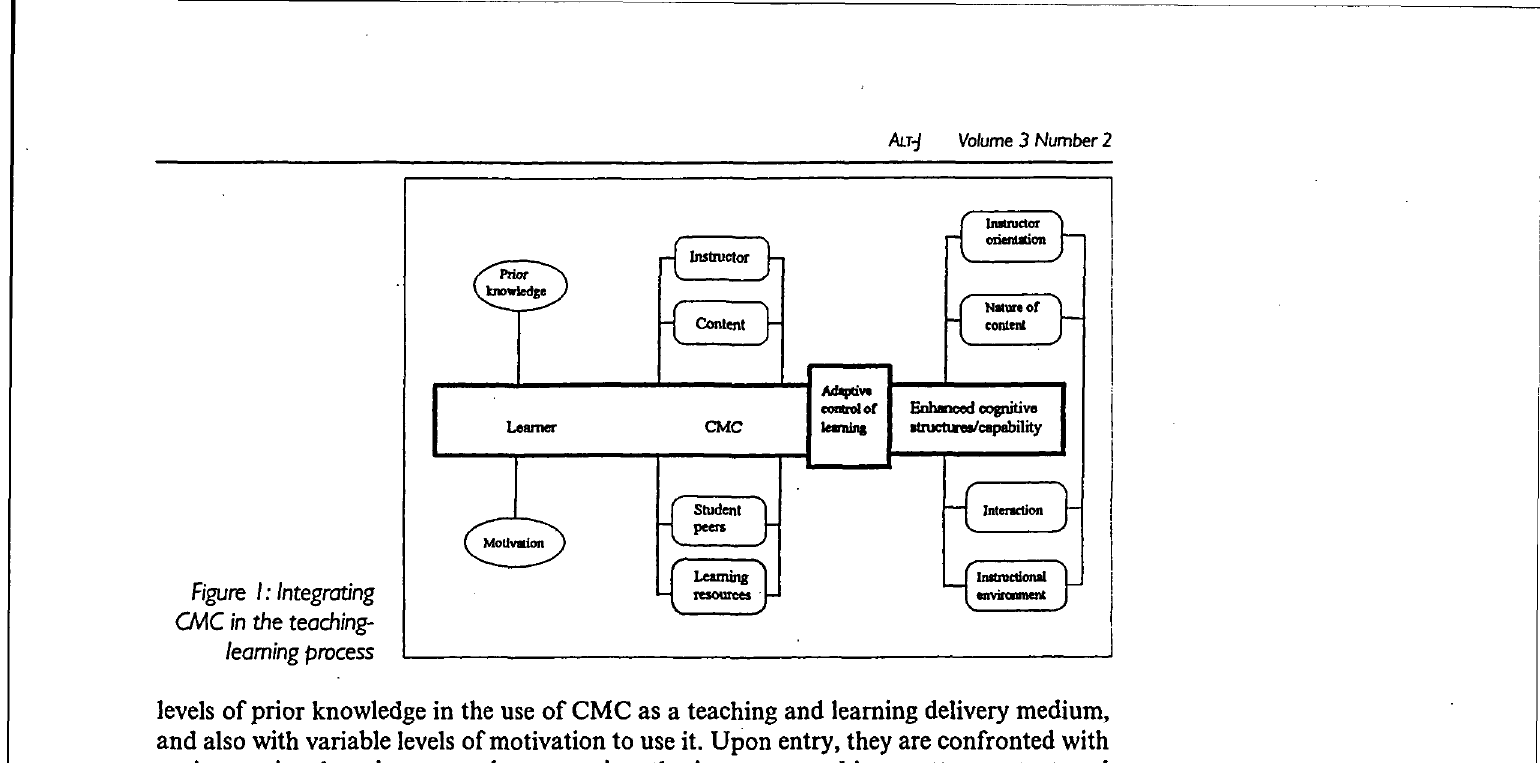
Figure I: Integrating CMC in the teoching- leaming